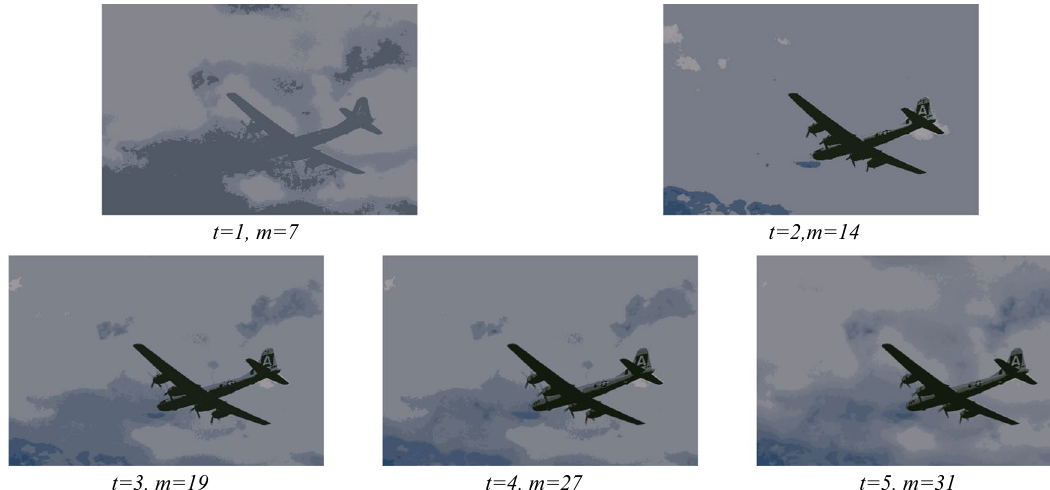
Fig. 8 Quantized 3096 image using CoG